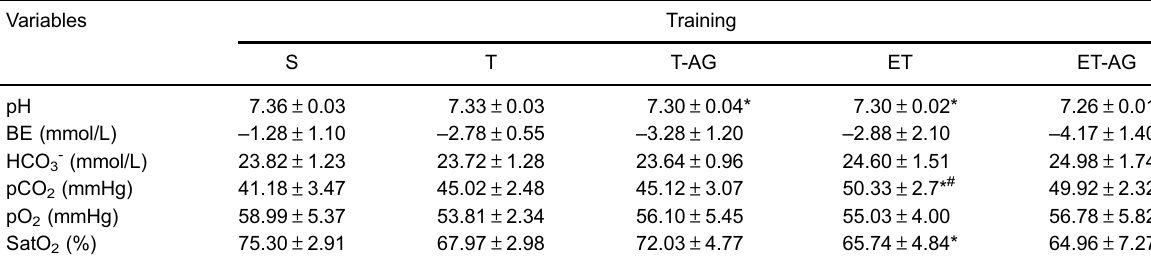
Table 1. Gasometric analysis